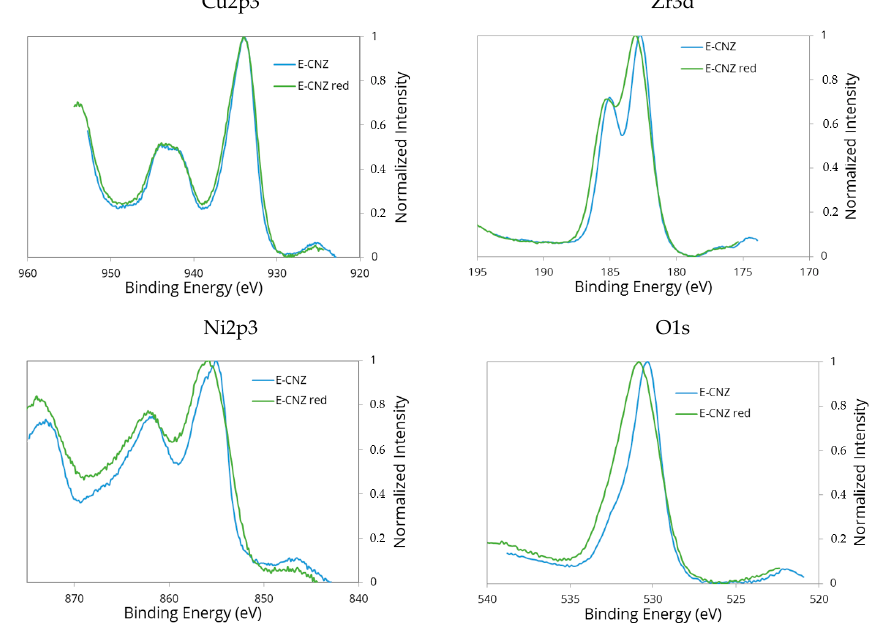
Figure 5. Cu2p 3 / 2 -, Ni2p 3 / 2 -, Zr3d 5 / 2 -, and O1s-lines in the XPS spectra of the calcined (blue) and reduced Figure 5. Cu2p 3/2 -, Ni2p 3/2 -, Zr3d 5/2 -, and O1s-lines in the XPS spectra of the calcined (blue) and E-CNZ sample reduced E-CNZ sample (green).